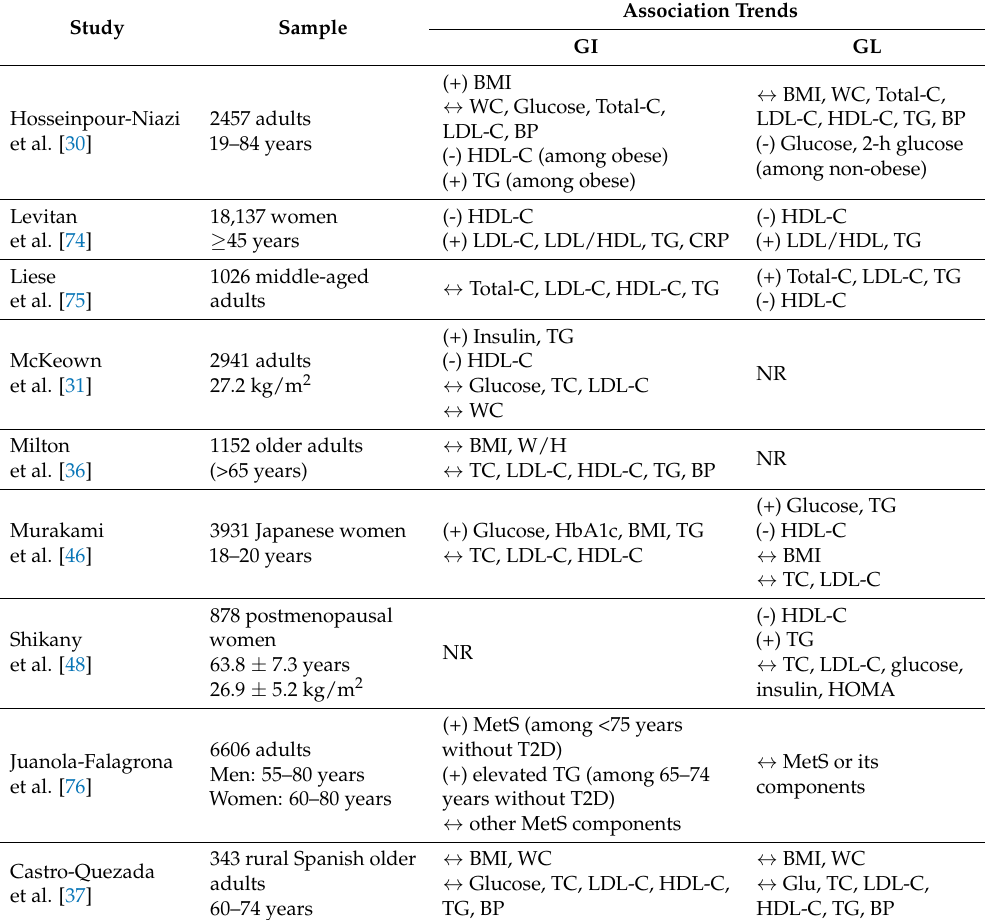
Table 8. Cross-sectional studies assessing the effects glycemic index or glycemic load on cardiovascular disease risk factors 1